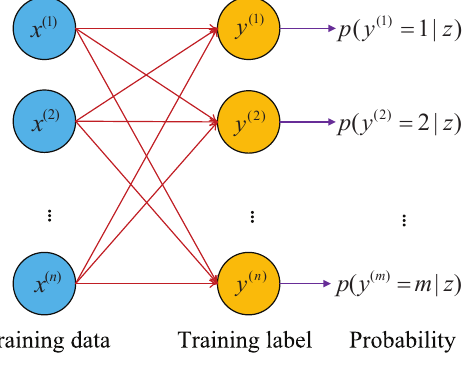
Figure 2. SoftMax regression